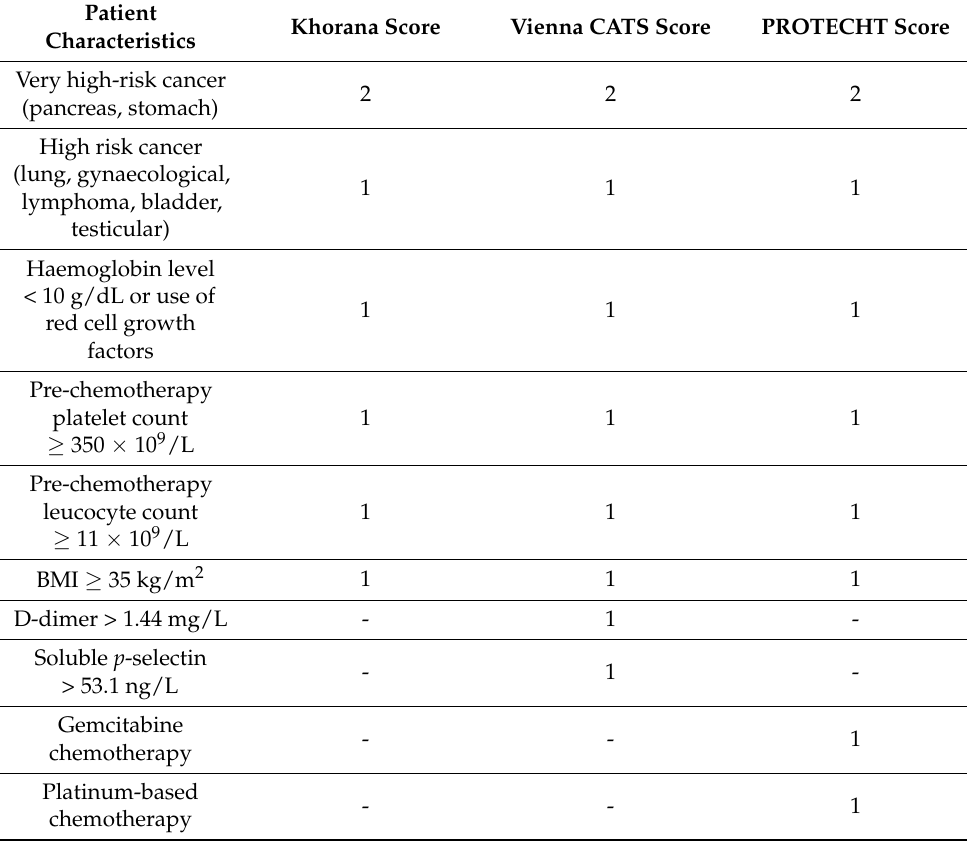
Table 2. Predictive risk scores for venous thromboembolism in cancer